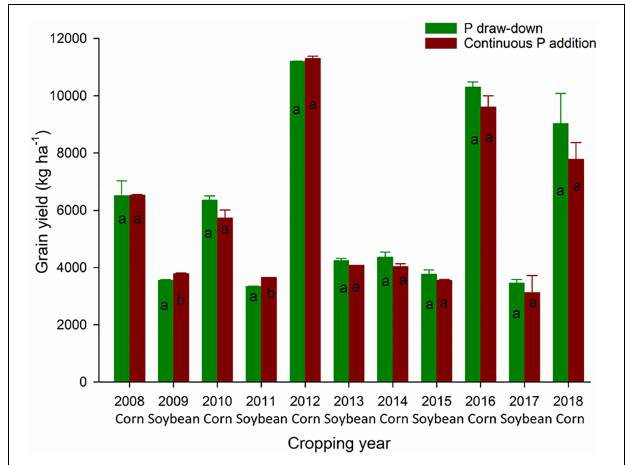
FIGURE 1 | Corn (2008, 2010, 2012, 2014, 2016, and 2018) and soybean (2009, 2011, 2013, 2015, and 2017) grain yields with continuous fertilizer P addition and soil P draw-down. Bars (means) labeled with the same lowercase letter above each year are not significantly different at P ≤ 0.05 levels. The vertical T-bars are standard errors ( n = 2).